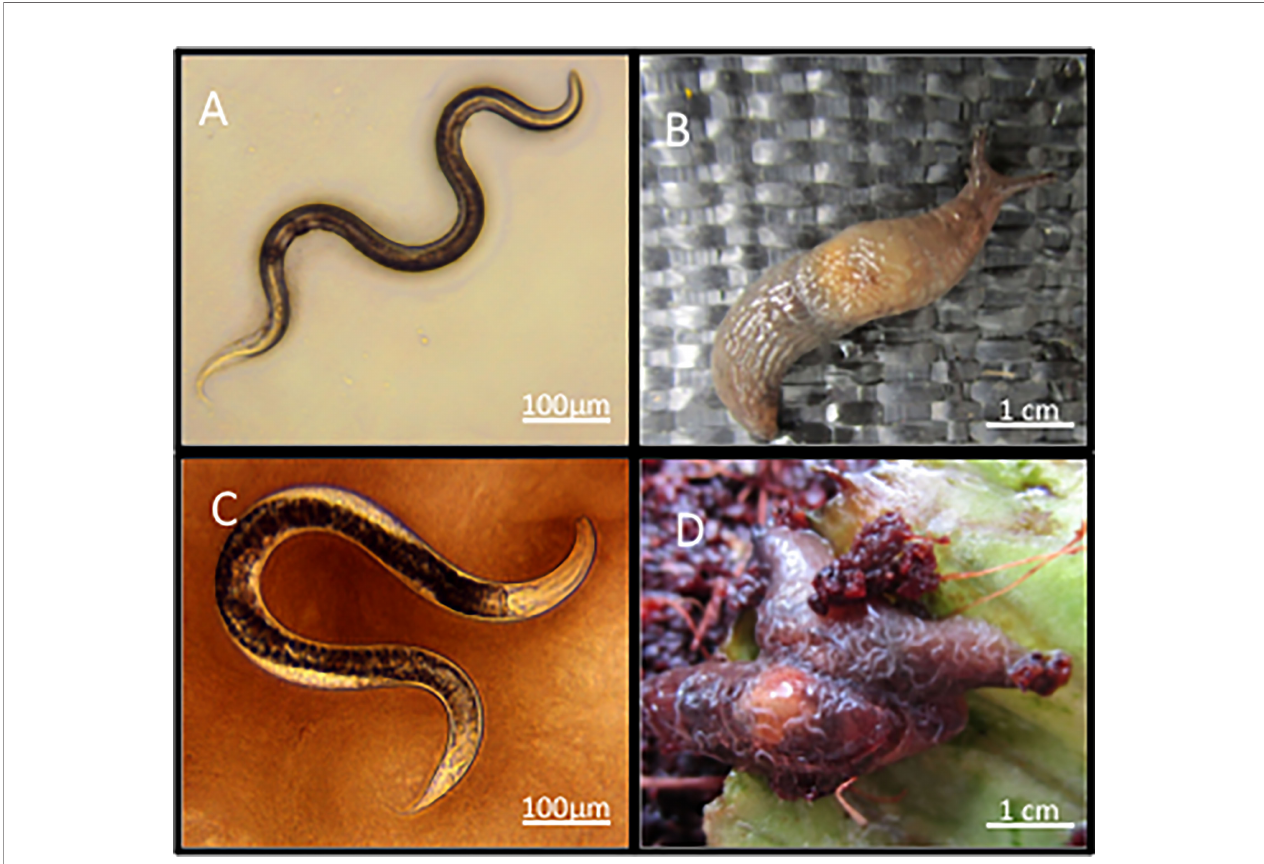
FIGURE 1 | Infective juvenile stage P. hermaphrodita (A) can infect and kill the susceptible slug D. invadens (B) and will develop to adults (C) and reproduce on the slug cadaver (D)